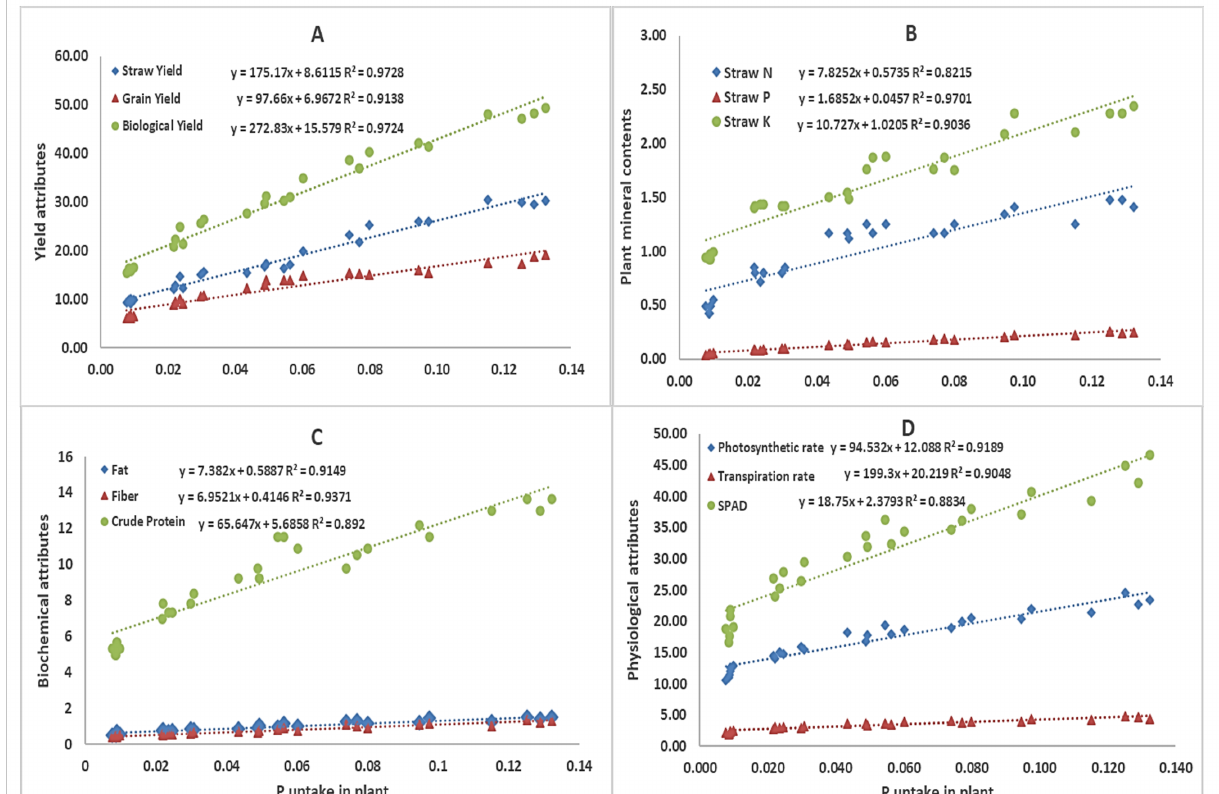
Figure 5. Relationship among plant P uptake and different yield ( A ), nutritional ( B ), biochemical ( C ) and ( D ) physiological attributes of wheat ( n =